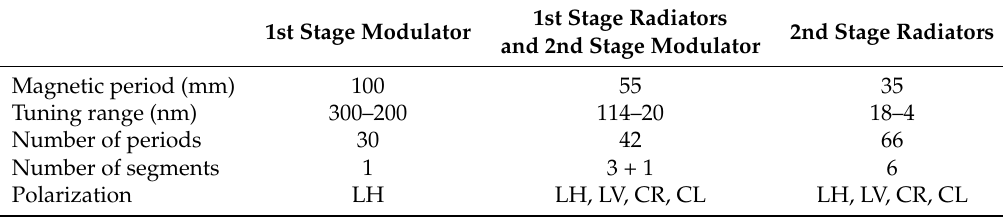
Table 3. Main parameters of the FERMI FEL-2 undulators. The tuning ranges are given for an electron beam energy between 1.0 and 1.5 GeV. The polarization states are abbreviated as LH: linear horizontal, LV: linear vertical, CR: circular right, CL: circular left. 1st Stage Radiators 1st Stage Modulator 2nd Stage Radiators and 2nd Stage Modulator Magnetic period (mm) 100 55 35 Tuning range (nm) 300–200 114–20 18–4 Number of